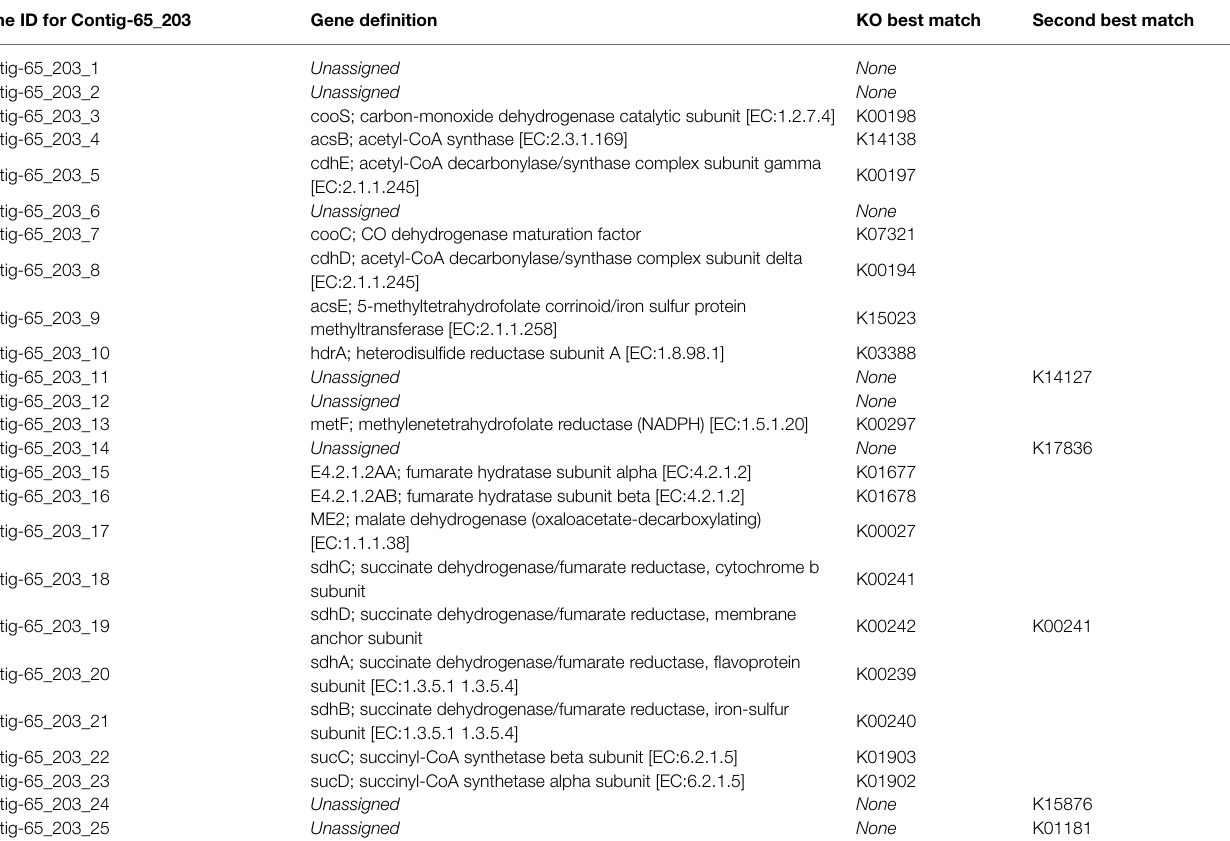
TABLE 1 | Kyoto Encyclopedia of Genes and Genomes (KEGG) annotations of contig-65_203 containing the acs gene cluster of the Wood–Ljungdahl pathway for carbon fixation. Gene ID for